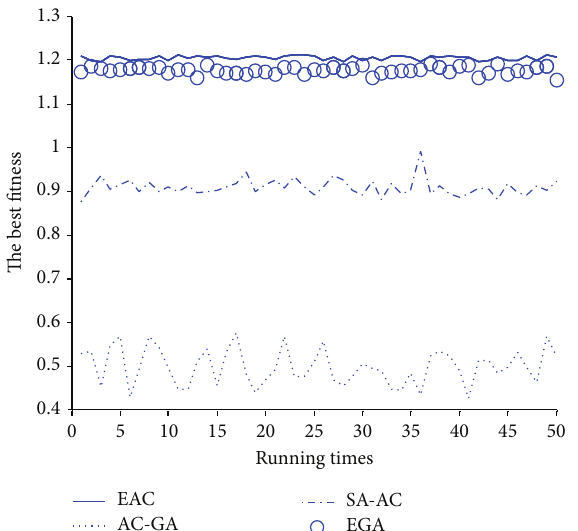
Figure 22: Convergence curves about the optimal fitness running 50 times on map III.